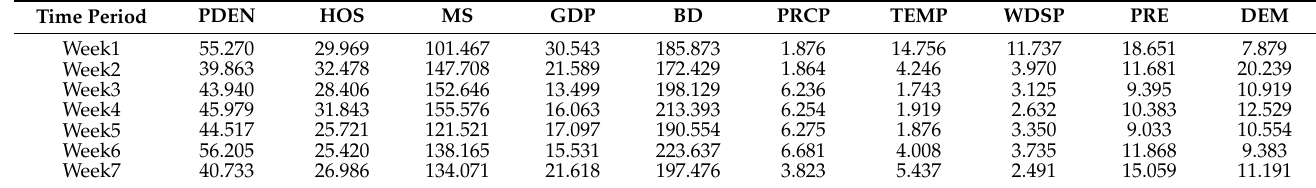
Table 3. Variance inflation factor (VIF) of exploratory variables in Hubei